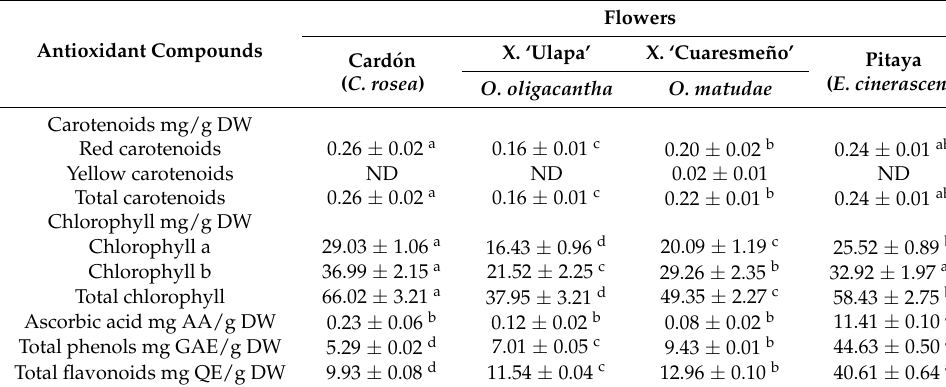
Table 2. Antioxidant compounds in cactus flowers from Hidalgo,